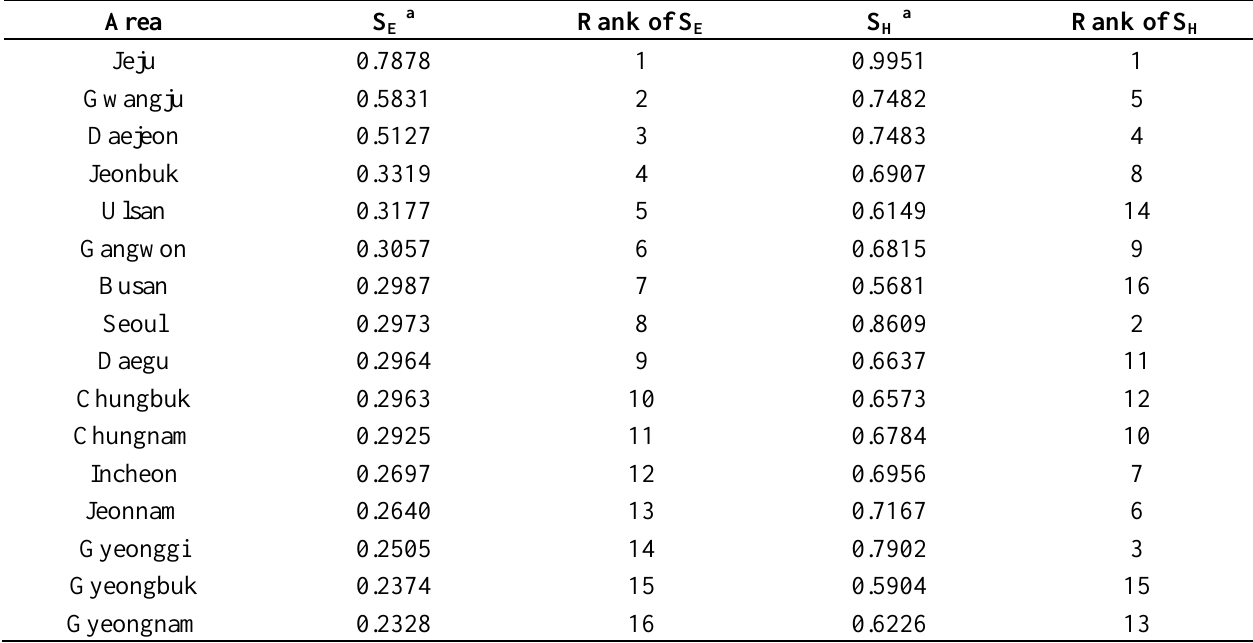
Table 3. The synthesized measures and ranking of environmental indicators and health status indicators in 16 study areas in Korea (2008–2009).